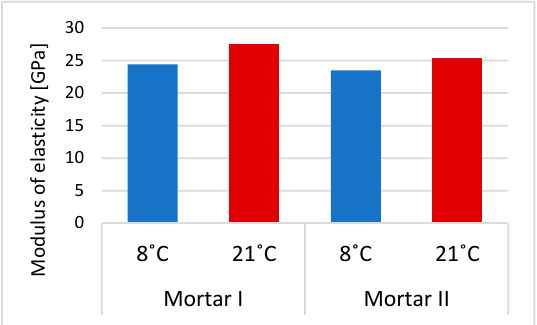
Figure 7. Di ff erences in the values of the elasticity modulus for PCC mortars curing at two temperatures: Figure 7. Differences in the values of the elasticity modulus for PCC mortars curing at two 8 ◦ C and 21 ◦ C. temperatures: 8 °C and 21 °C.